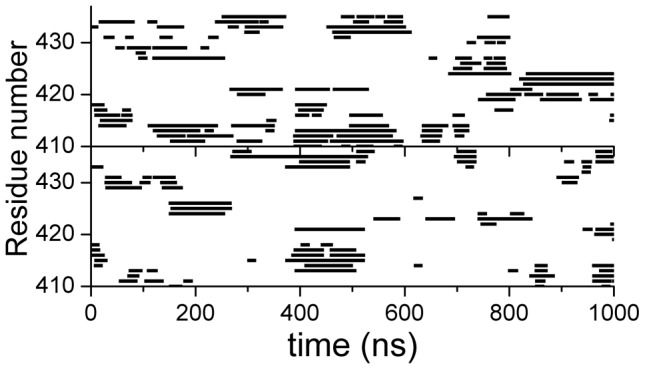
Binding of c-Myc410–437 with the S (upper) and R (lower) forms of 10074-A4.